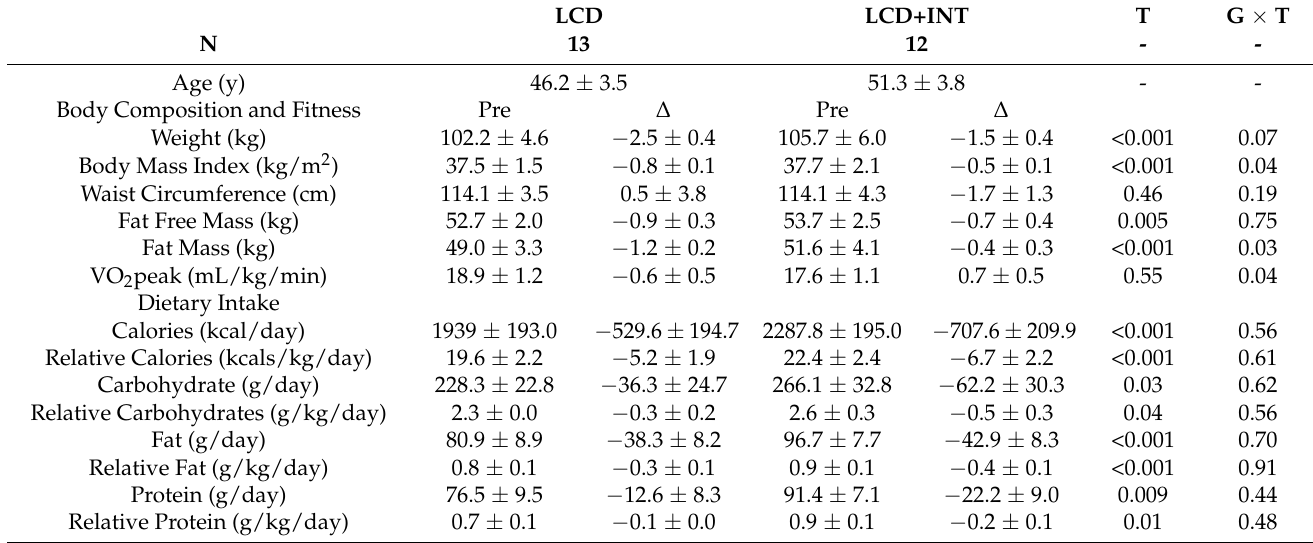
Note: Data expressed as mean ± SEM. VO 2 max: maximal oxygen uptake. Relative calories and macronutrients divided by body mass in kilograms. Change scores ( ∆ ) calculated Post minus Pre. T: p -value for time effect, G × T: p -value for group × time effect. Blood Lipids and Glucose Metabolism: LCD and LCD+INT reduced